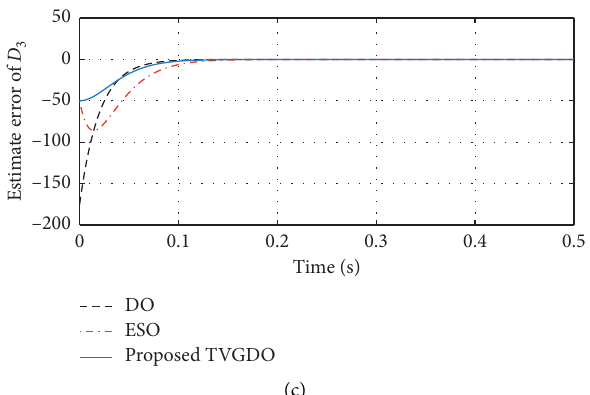
Figure 7: Estimate error (Case 2).